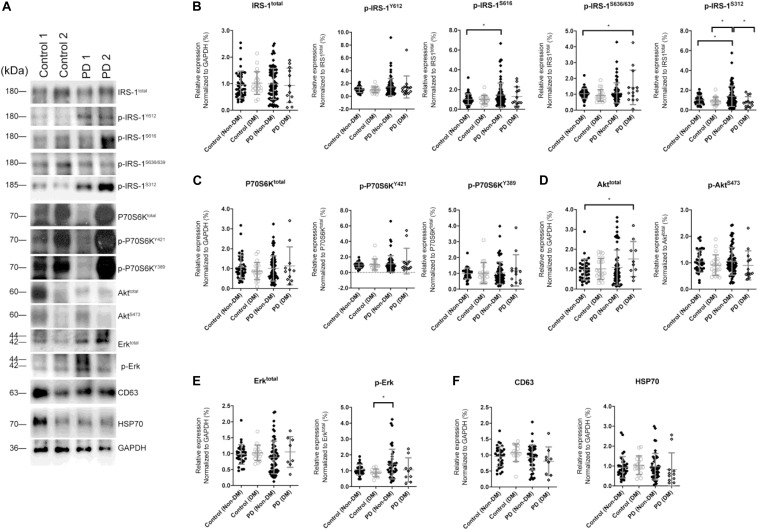
Total IRS-1, p-IRS-1 and downstream substrates level in blood neuron-derived extracellular vesicles. (A) The representative protein blot images of IRS-1 and different phosphorylated forms of IRS-1, including Y612, S616, S636/639, and S312. HSP70 and CD63 were exosomal proteins and markers. GAPDH was the protein loading control (1 and 2 indicate different samples). Comparison of the levels of total IRS-1, p-IRS-1Y612, p-IRS-1S616, p-IRS-1S636/639, p-IRS-1S312
(B), and downstream IRS-1 substrates (C–E) between healthy controls [with or without diabetes mellitus (DM)] and Parkinson’s disease (PD) patients (with or without DM). The phosphorylation status of IRS-1, P70S6K, Akt, and Erk was normalized to total form IRS-1, P70S6K, Akt, and Erk. (F) The EV markers–CD63 and HSP70 was not different between 4 groups. Data was presented as mean ± SEM. *p < 0.05.